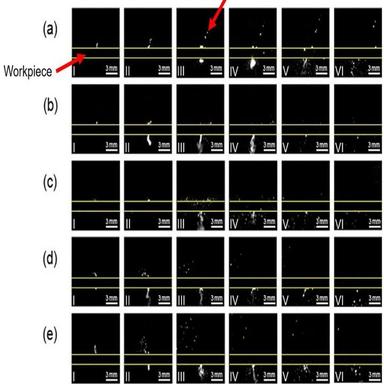
High-speed photography images showing the transient evolution of the through-hole drilling stage using the second laser pulse with different argon pressures of (a) 0.05 MPa, (b) 0.1 MPa, (c) 0.15 MPa, (d) 0.2 MPa and (e) 0.25 MPa.